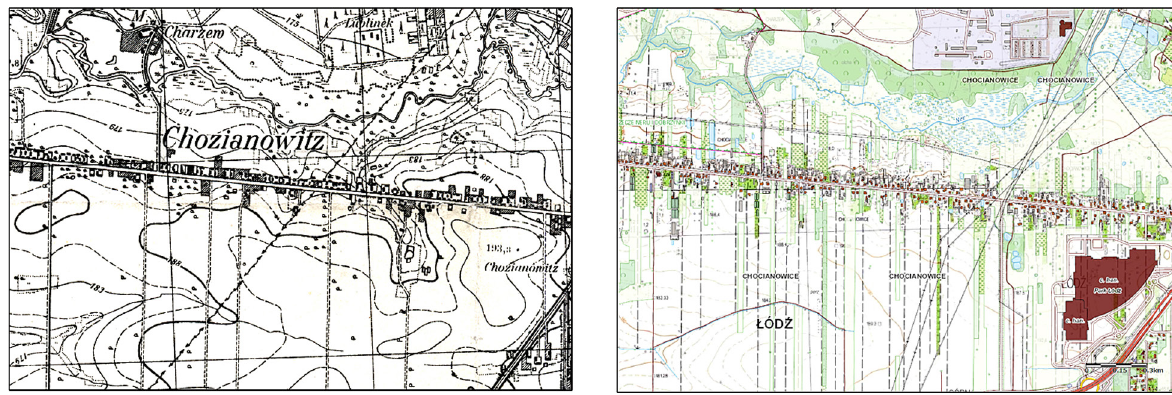
Fig. 3. Morphological changes in the former village of